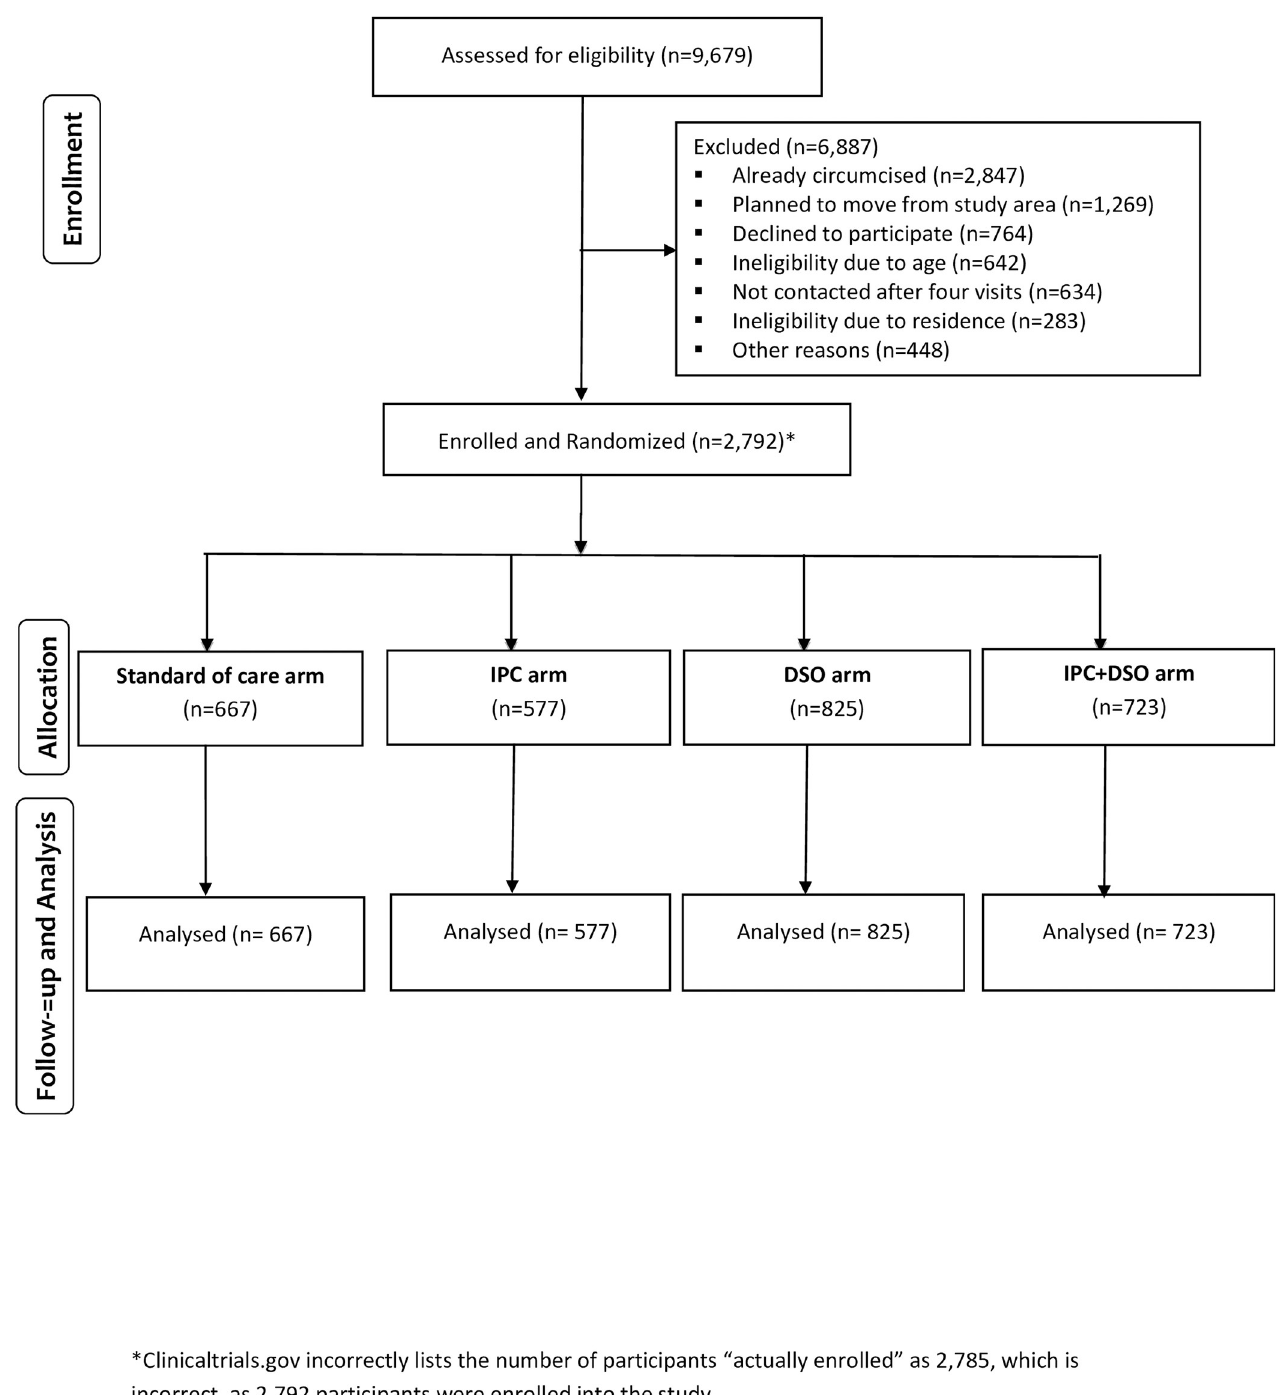
Fig 1. Participant screening, enrollment, and follow-up. � Clinicaltrials.gov incorrectly lists the number of participants “actually enrolled” as 2,785, which is incorrect, as 2,792 participants were enrolled into the study.